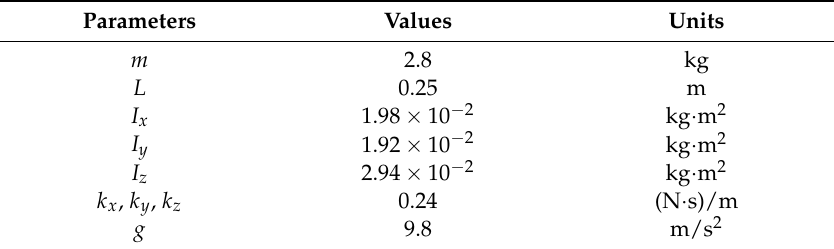
Table 1. Physical parameters of the quadrotor UAV.